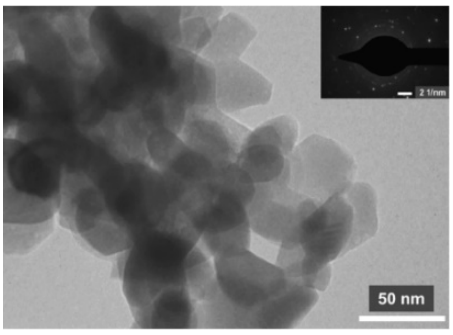
Figure 2. TEM and SAED images of ZnFe 2 O 4 powder [17].